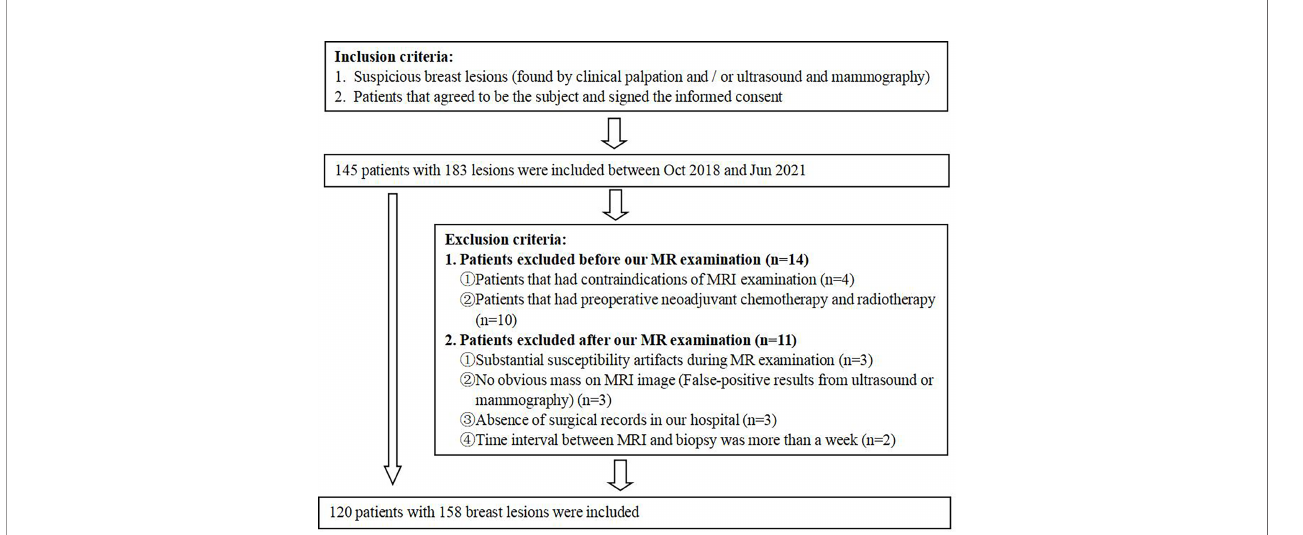
FIGURE 1 | Flowchart of the study